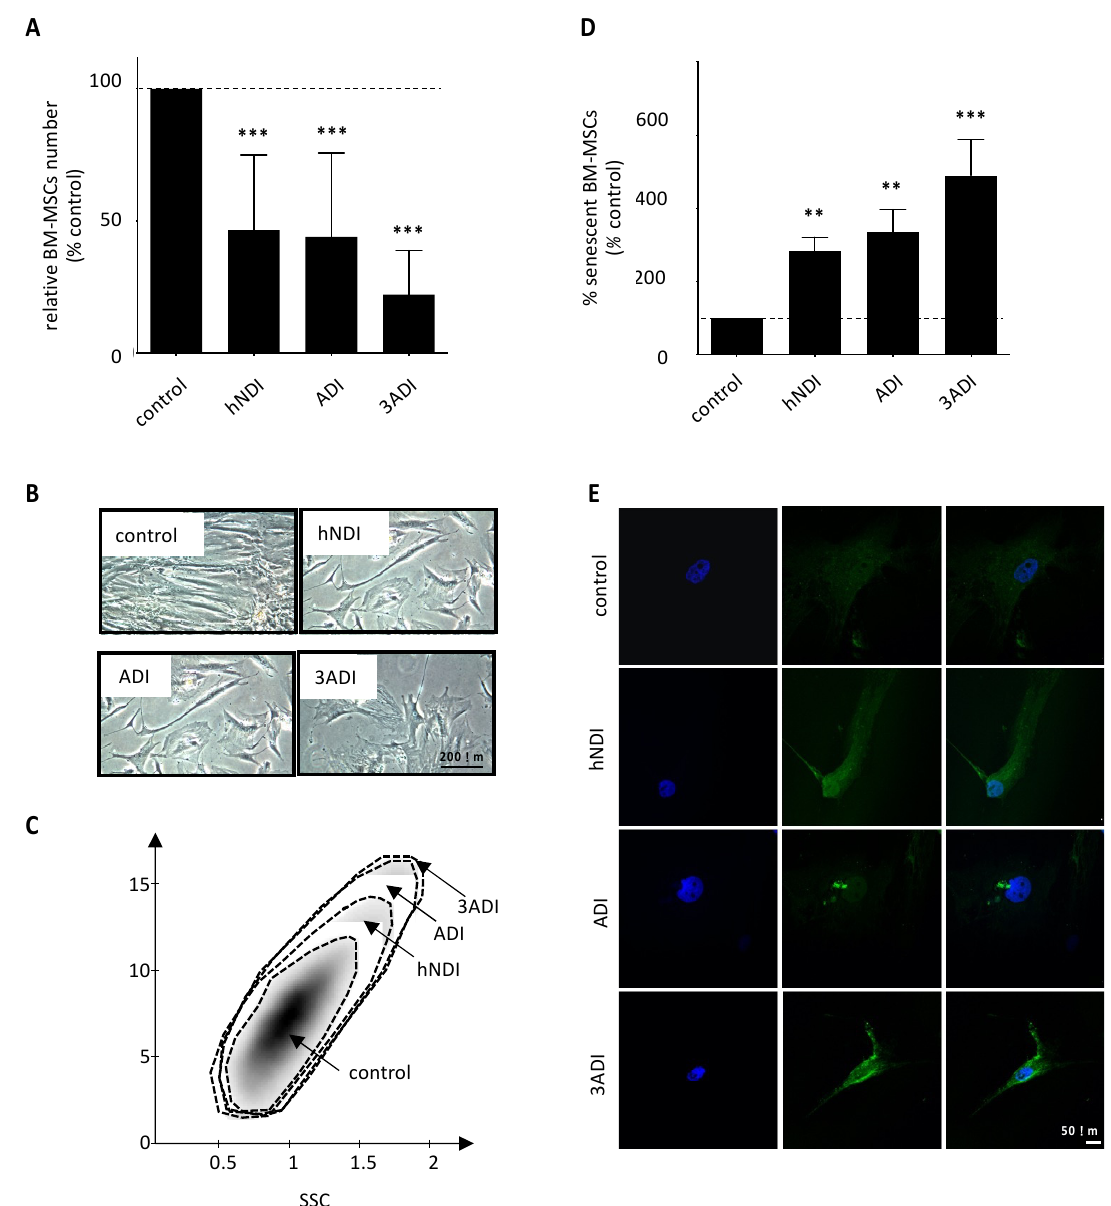
Figure 1. BM-MSCs enumeration and senescence are impacted after 21 days of pesticide exposure. ( A ) BM-MSCs enumeration (Trypan blue exclusion method) indicates a lower number of cells after exposure to pesticides (hNDI, ADI, 3ADI, n = 36) for 21 days in vitro. ( B ) Representative bright-field micrographs of BM-MSCs after 21 days of exposure and ( C ) representative forward-scatter (FCS) and side-scatter (SSC) flow cytometry plot, revealing abnormal cell morphology after pesticides exposure. ( D ) β -galactosidase activity in BM-MSCs indicates a higher number of positive cells (senescent cells) after pesticide exposure ( n = 11), and ( E ) anti- β -Galactosidase immunostaining confirms these results. Data are expressed as percent of the control ± SEM; **, p < 0.001; ***, p < 0.0001; Friedman or Kruskall–Wallis followed by post hoc multiple comparisons test. Scalebars: 200 µ m ( B ) and 50 µ m ( E